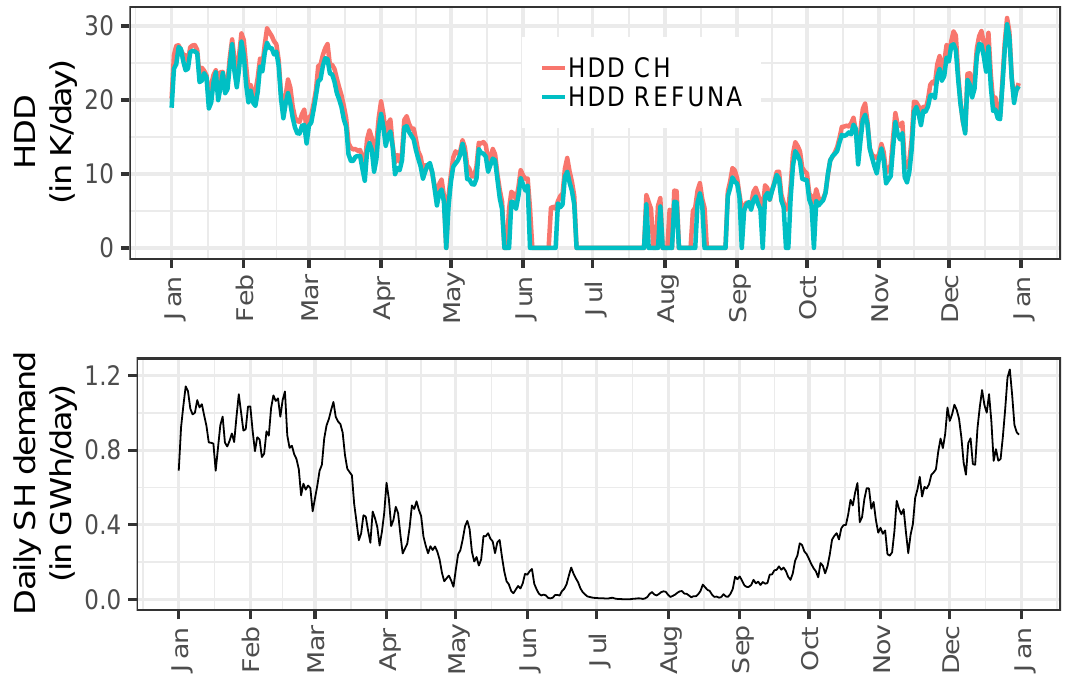
Figure 4. ( Top ): Heating degree days (HDD) in the REFUNA area and (population-weighted) Switzerland (CH). ( Bottom ): Daily space heating (SH) demand in REFUNA derived from actual heat feed-in